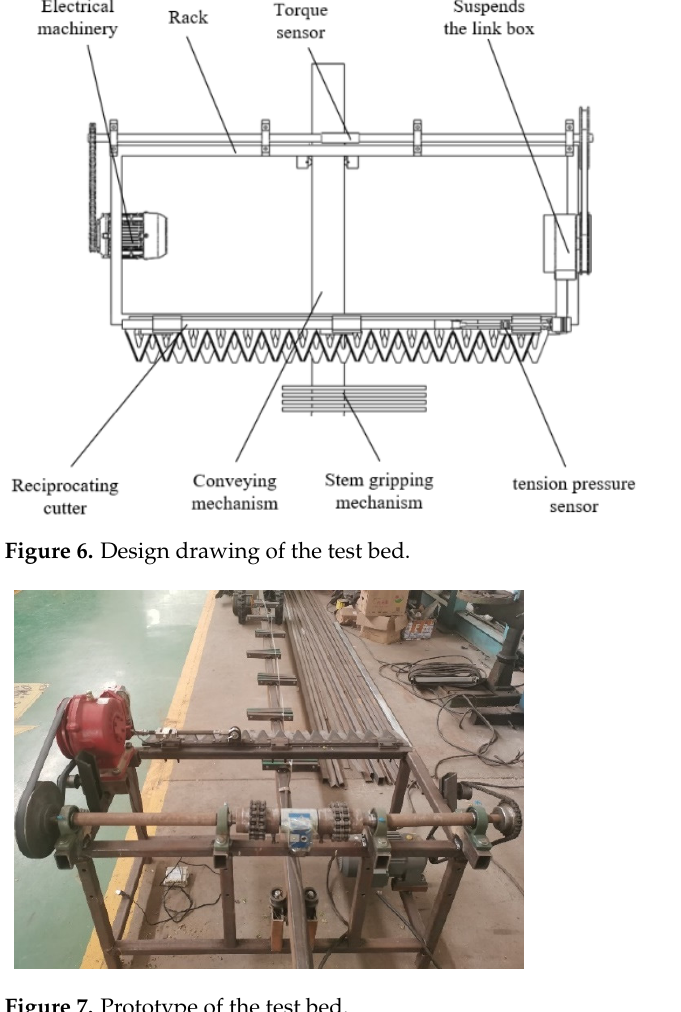
Figure 7. Prototype of the test bed.